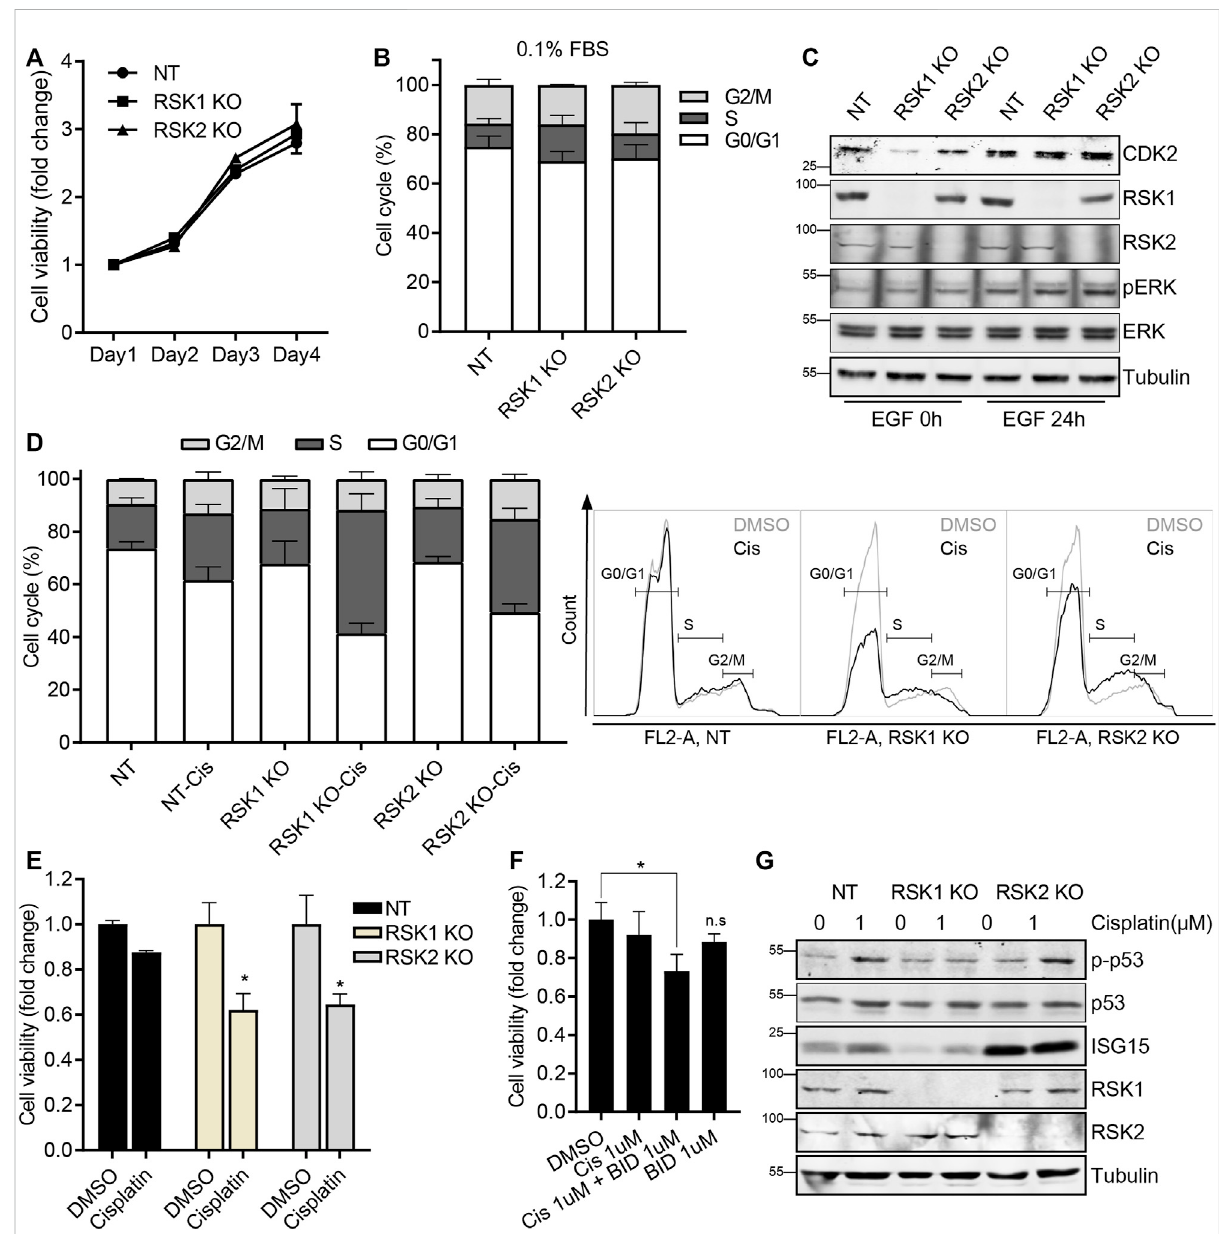
RSK1 regulates cell cycle and DNA repair pathways (A) XTT assay of U251 non-target (NT), RSK1 KO, and RSK2 KO cells. (B) Cell cycle analysis of threecelllinesafterstarvingin0.1%FBSovernight.Thebargraphshowsthepercentageofcellsineachphaseofthecellcycle(G0/G1,S,andG2). (C) Representative western blot analysis of three cell lines in 0.1% FBS starved conditions, and after EGF stimulation. pERK was used as a positive control for the EGF treatment, and tubulin was used as an internal control. (D) Cell cycle analysis of three cell lines after 24 h cisplatin (1 µM) treatment, andtheresultingS-phaseincrease.Left,bargraphshowingthepercentageofcellsineachphaseofthecellcycle(G0/G1,S,andG2).Right,histogram of fl ow cytometry overlapping with or without cisplatin treatment. (E) XTT assay of three cell lines after 48 h cisplatin (1 µM) treatment. (F) XTT assay of U251 wild-type cells treated for 48 h with cisplatin (1 μ M, alone), BI-D1870 (1 μ M, alone), or the combination of cisplatin plus BI-D1870. (G) Representativewesternblotanalysisofthreecelllinesaftercisplatintreatmentfor24 h.Allbargraphsrepresentaveragevaluesofthreeexperiments, with error bars indicating the standard deviation. *, p < 0.05; n. s, not signi fi